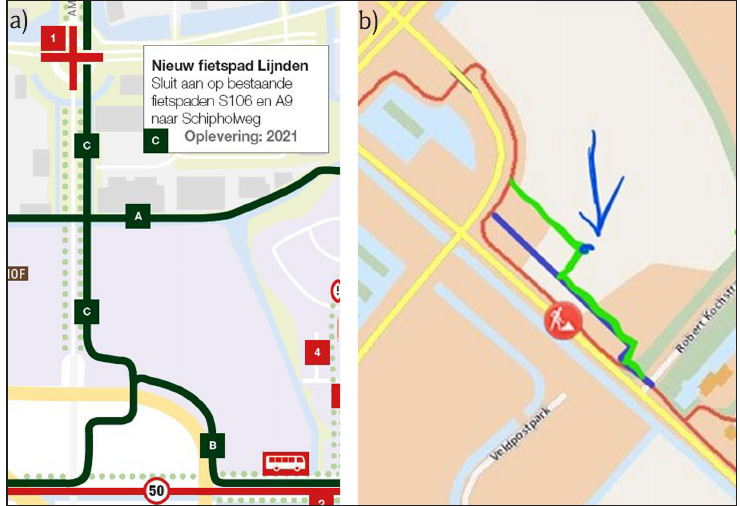
Figure 6: Design and future plan—hardly signalling improvement (Provincie Noord-Holland 2019; Gemeente Haarlemmermeer